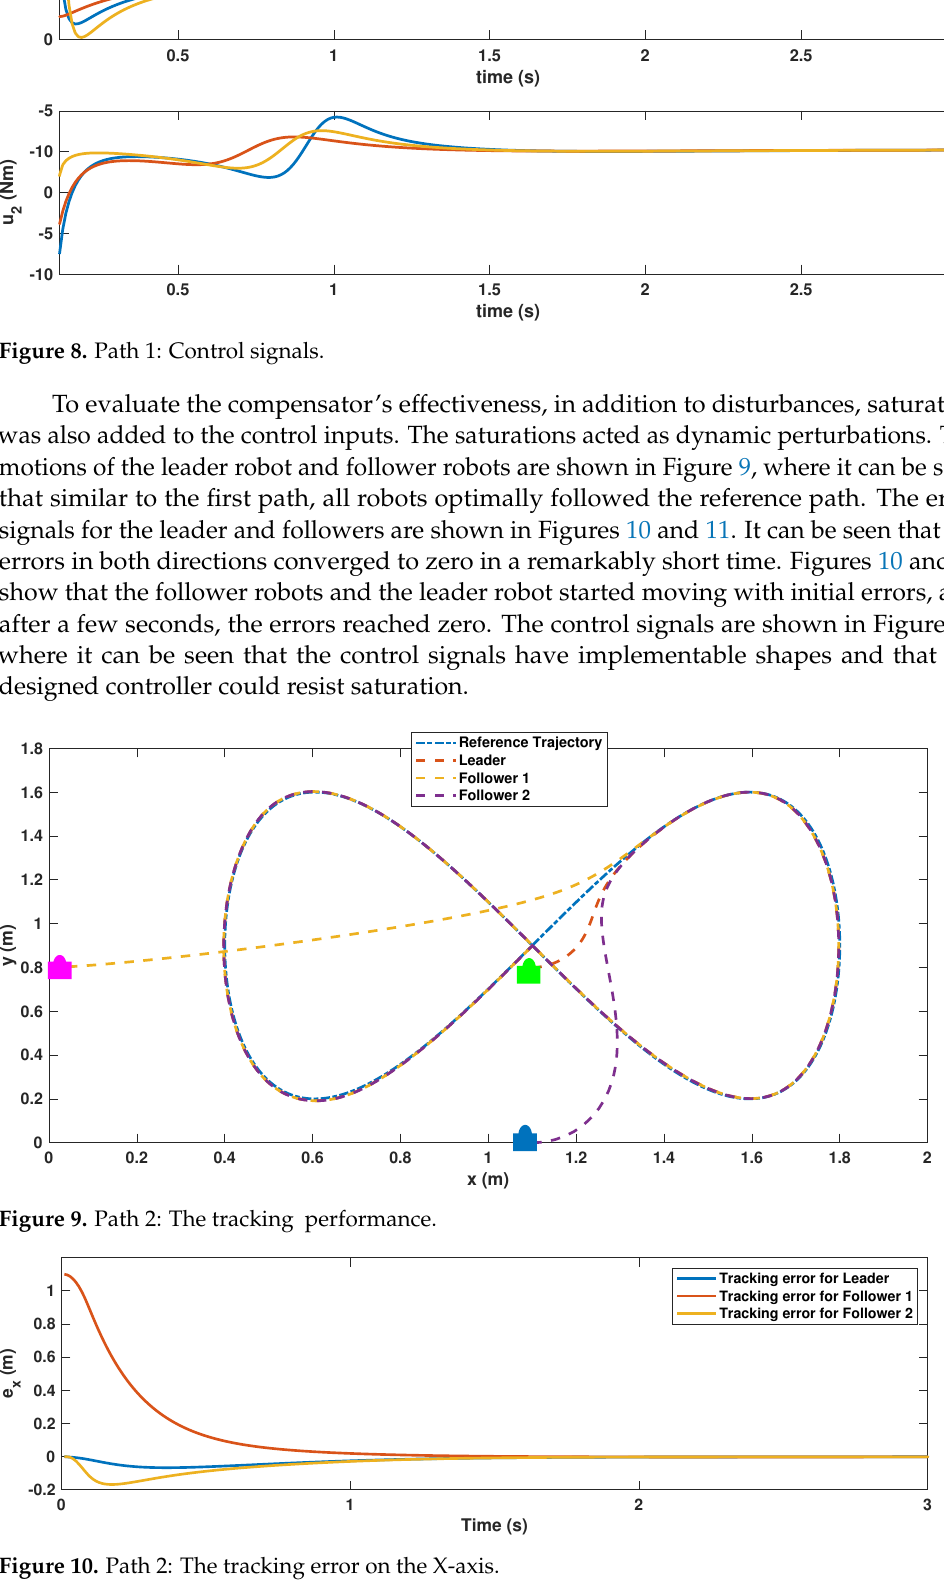
Figure 10. Path 2: The tracking error on the